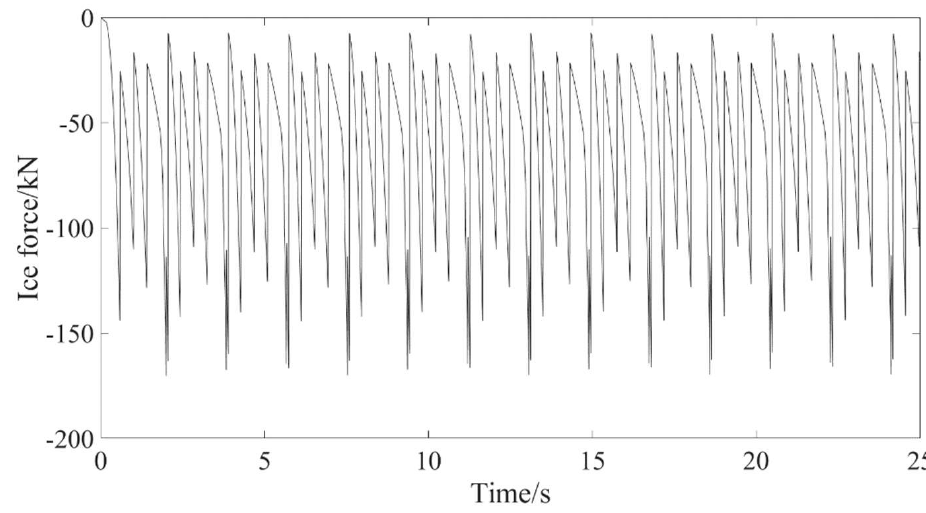
Figure 9. Time history curves of total ice force in case 3.